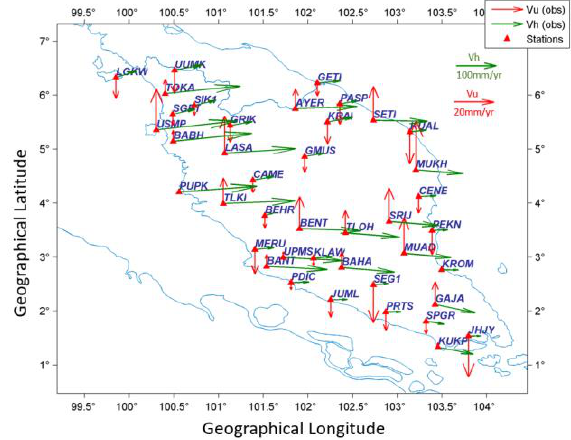
Figure 9. Site velocities in Peninsular Malaysia as estimated from forty-one (41) MyRTKnet sites in 2012